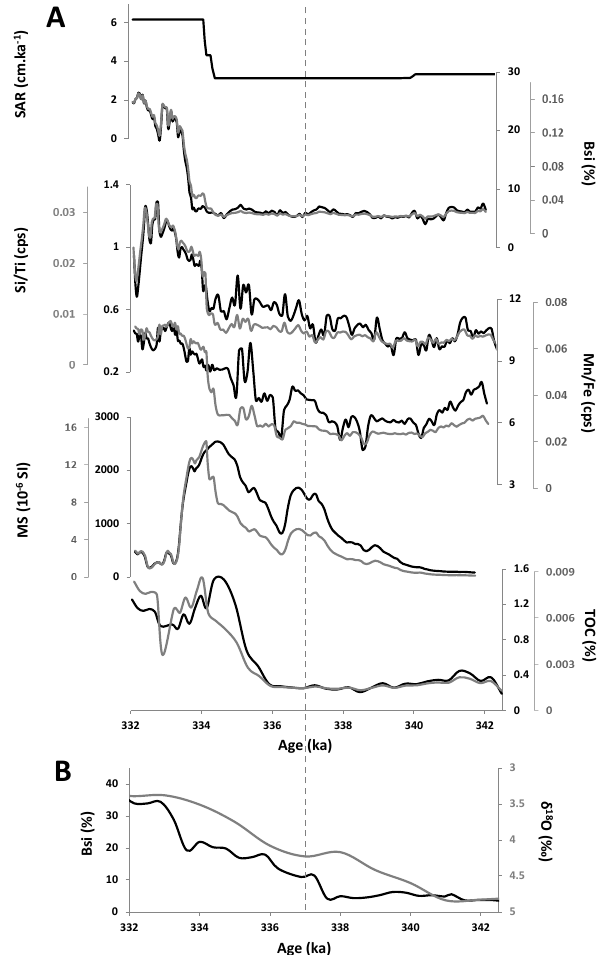
Fig. 2. (A) : Sediment accumulation rates (SAR) and high-resolution reconstructions of the geochemical proxies: biogenic silica (BSi), silica/titanium (Si/Ti), manganese/iron (Mn/Fe), magnetic suscepti- bility (MS) and total organic carbon (TOC) from Lake El’gygytgyn during Termination IV. The black lines indicate the initial proxy data; the grey lines illustrate the proxy series divided by the time period that it took each sample to accumulate. (B) : comparisons with the lower resolution biogenic silica record from Lake Baikal (Prokopenko et al., 2006; black line) and the stacked marine δ 18 O record (Lisiecki and Raymo, 2005; grey line) reflect a general syn- chronicity of timing, given the potential chronological errors associ- ated with these records. The vertical dashed line indicates the timing of boundary between MIS9 and MIS10 suggested by Lisiecki and Raymo